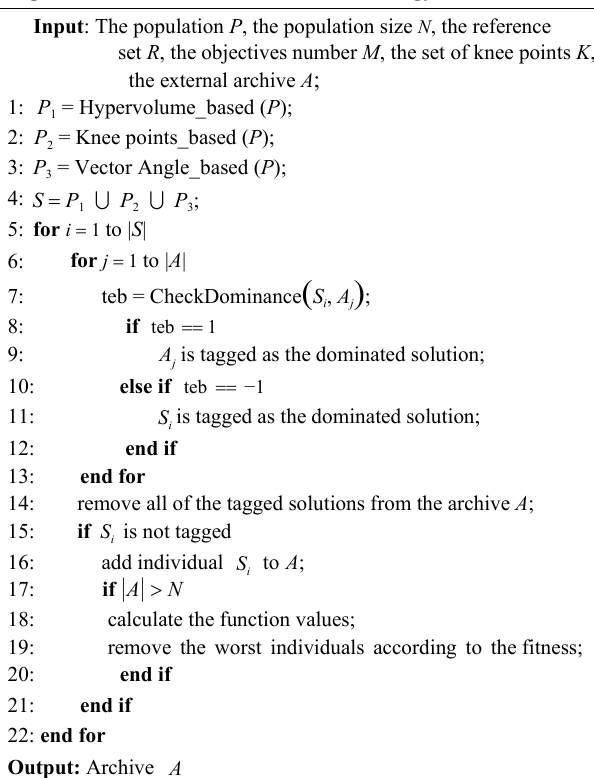
Algorithm 1 Elite individual retention